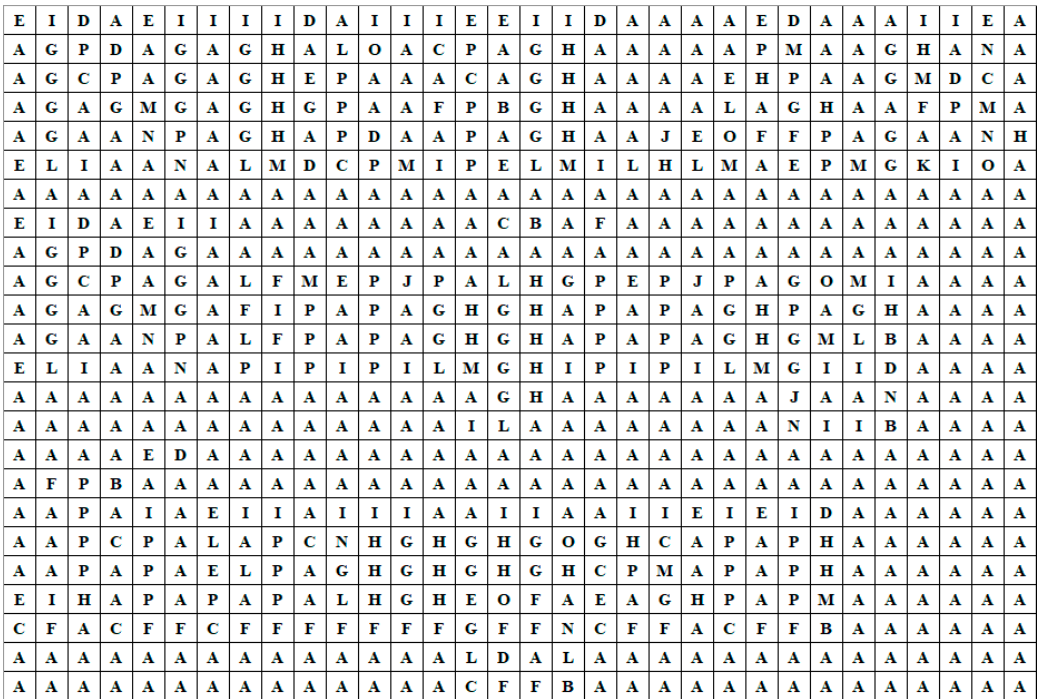
Figure 11. Results of single-value replacement taking the original copyright watermark data as an example. Table 5. Results of Huffman coding taking the original copyright watermark data as an example.